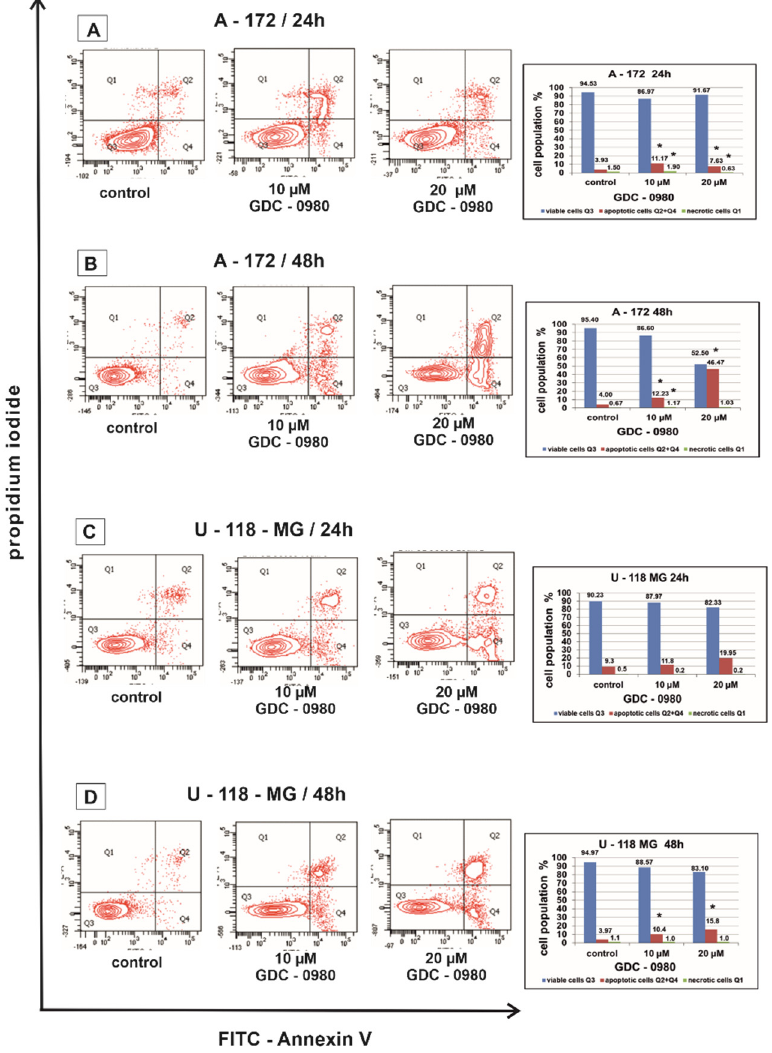
Figure 4. The effect of GDC-0980 inhibitor on apoptosis and necrosis of A-172 ( A , B ) and U-118-MG ( C , D ) cells evaluated by Annexin V assay. The cells were incubated for 24 and 48 h in Dulbecco’s modified Eagle medium (DMEM) with 10 and 20 µM of GDC-0980. The cells were double-stained with Fluorescein Isothiocyanate (FITC)-Annexin V and propidium iodide (PI). Representative flow cytometry (FACS) analysis via Annexin V-FITC/PI staining for 24 h and 48 h is presented. The bar graphs present the percentage of apoptotic cells as a sum of Q2 and Q4 quadrants and necrotic cells as a Q1 quadrant of the analysed cell population. Mean values of the percentage of apoptotic and necrotic cells from three independent experiments ± SD are presented. Note: signifi- cant alterations are expressed relative to controls and marked with asterisks: * p < 0.05. Statistical significance was considered if p <